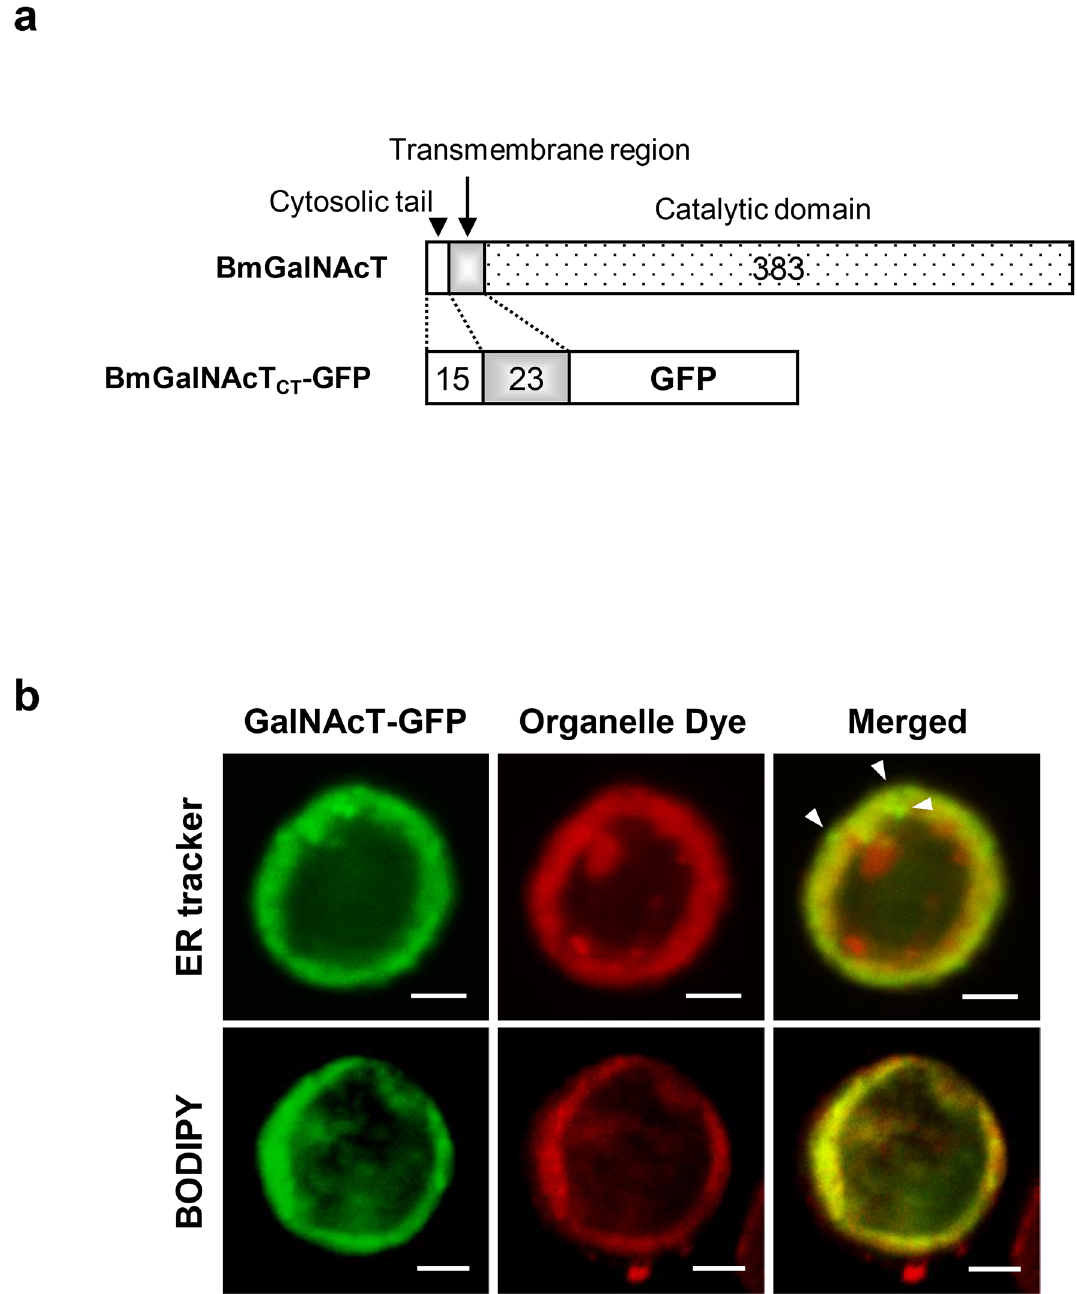
Figure 1. Subcellular localization of BmGalNAcT. ( a ) Schematic representation of the fusion protein of BmGalNAcT CT -GFP. The putative cytosolic and transmembrane regions were fused to the N-terminus of GFP. Black dotted, gray, and white boxes indicate the putative cytosolic region, transmembrane region, and catalytic region including the stem region of BmGalNAcT. The numbers indicate the length of each region. ( b ) Dual-color-imaging of BmGalNAcT CT -GFP-expressing Sf9 cells stained with organelle dyes. (Top) Imaging of BmGalNAcT CT -GFP-expressing cells stained with ER marker. BmGalNAcT CT -GFPs without overlapping ER marker are indicated by white triangles (bottom) Imaging of BmGalNAcT CT -GFP expressing cells stained with BODIPY TR Ceramide as Golgi marker. Bars: 10